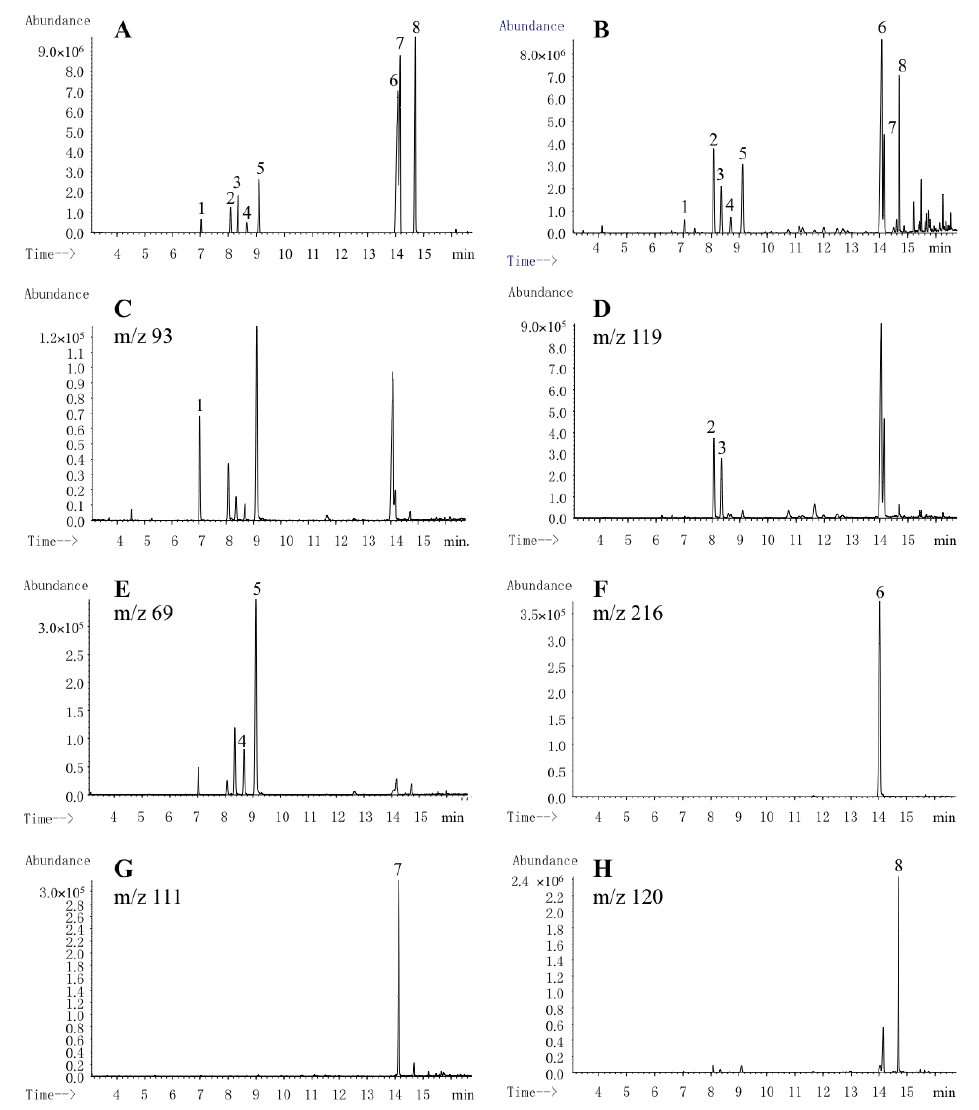
Figure 4. GC–MS total ion chromatogram of mixed standards ( A ), PLE extract ( B ) and the selected ion chromatograms for ( C ) β-caryophyllene, ( D ) ar-curcumene + zingiberene, ( E ) β-bisabolene + β-sesquiphellandrene, ( F ) ar-turmerone, ( G ) α-turmerone, and ( H ) β-turmerone.